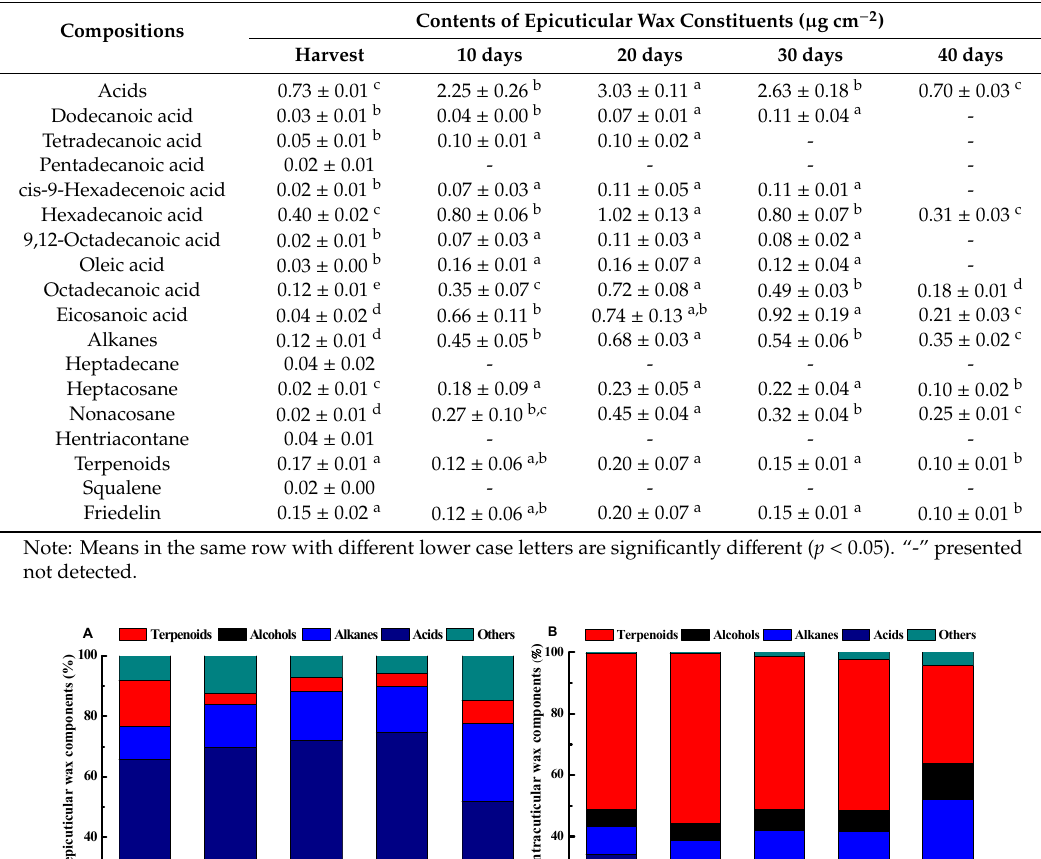
Table 2. Epicuticular wax constituents of ‘Satsuma’ mandarin fruits during storage.